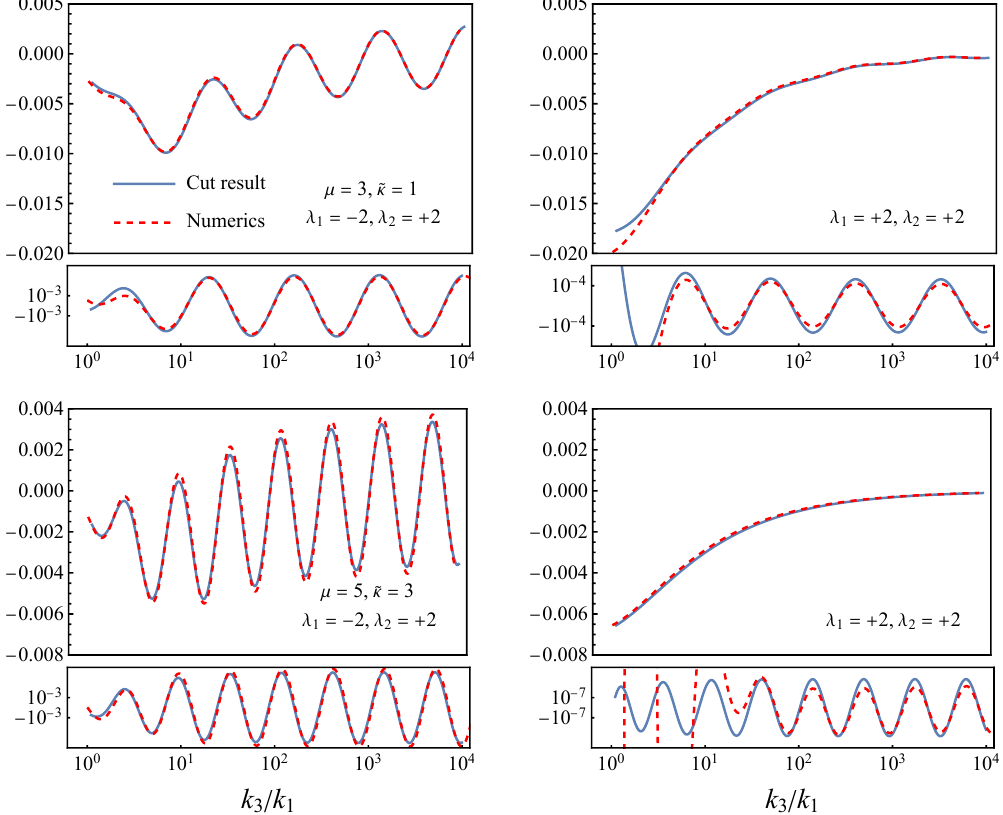
γ λ ζ i correlator for different choices of mass µ and chemical ( i ) 1 2 h γ λ ( k 1 ) γ λ ( k 1 ) ζ ( k 3 ) i 0 / ρ 2 H 4 , with 1 ( i ) M 4 p 1 2